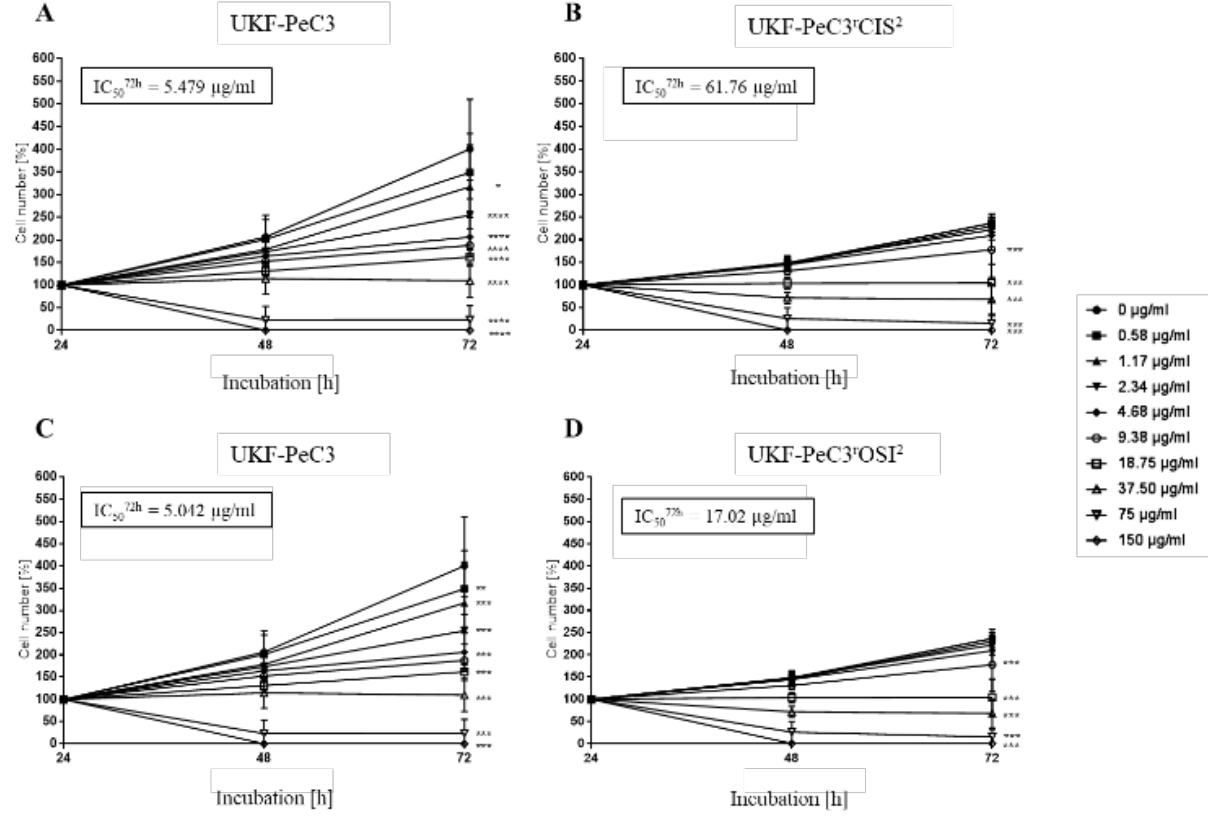
Figure 3. Tumor cell growth of UKF-PeC3 ( A , C ), UKF-PeC3 r CIS 2 ( B ), and PeC3 r OSI 2 ( D ) cells after 24, 48, and 72 h treatment with ascending cisplatin ( A , B ) or osimertinib ( C , D ) concentrations. The cell number was set to 100% after 24 h incubation. The IC 50 of cisplatin and osimertinib after 72 h treatment is specified. Error bars indicate the standard deviation (SD). Significant difference from untreated control: * = p ≤ 0.05, ** = p ≤ 0.01, *** = p ≤ 0.001.